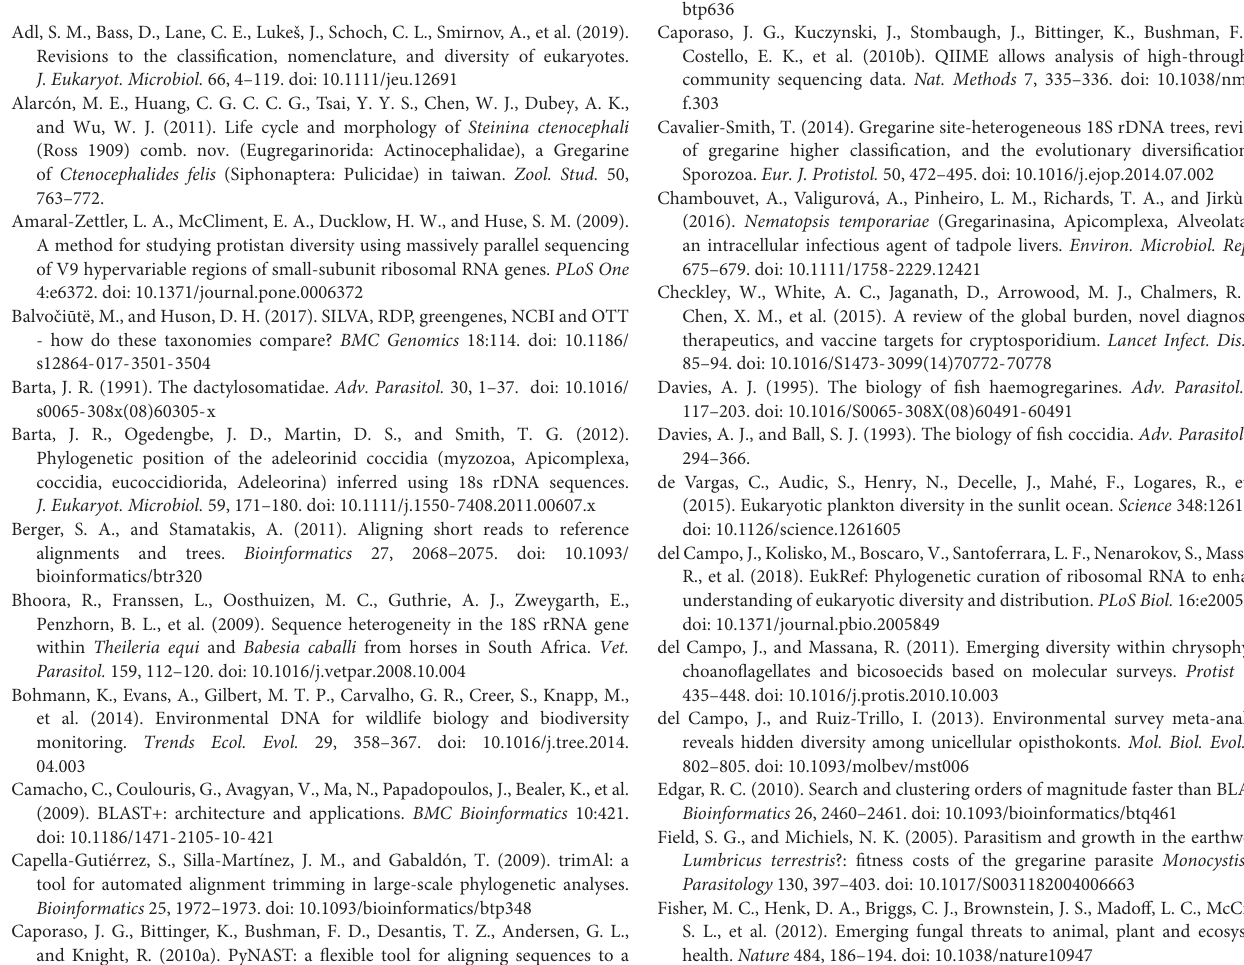
TABLE S1 | Apicomplexan reference database built from 18S rRNA sequences bigger than 500 bp retrieved from GenBank. The database contains the following columns: AN, sequence accession number; Columns 0–6, taxonomic string; Name, name given to the sequence in GenBank; Origin, isolate or environmental